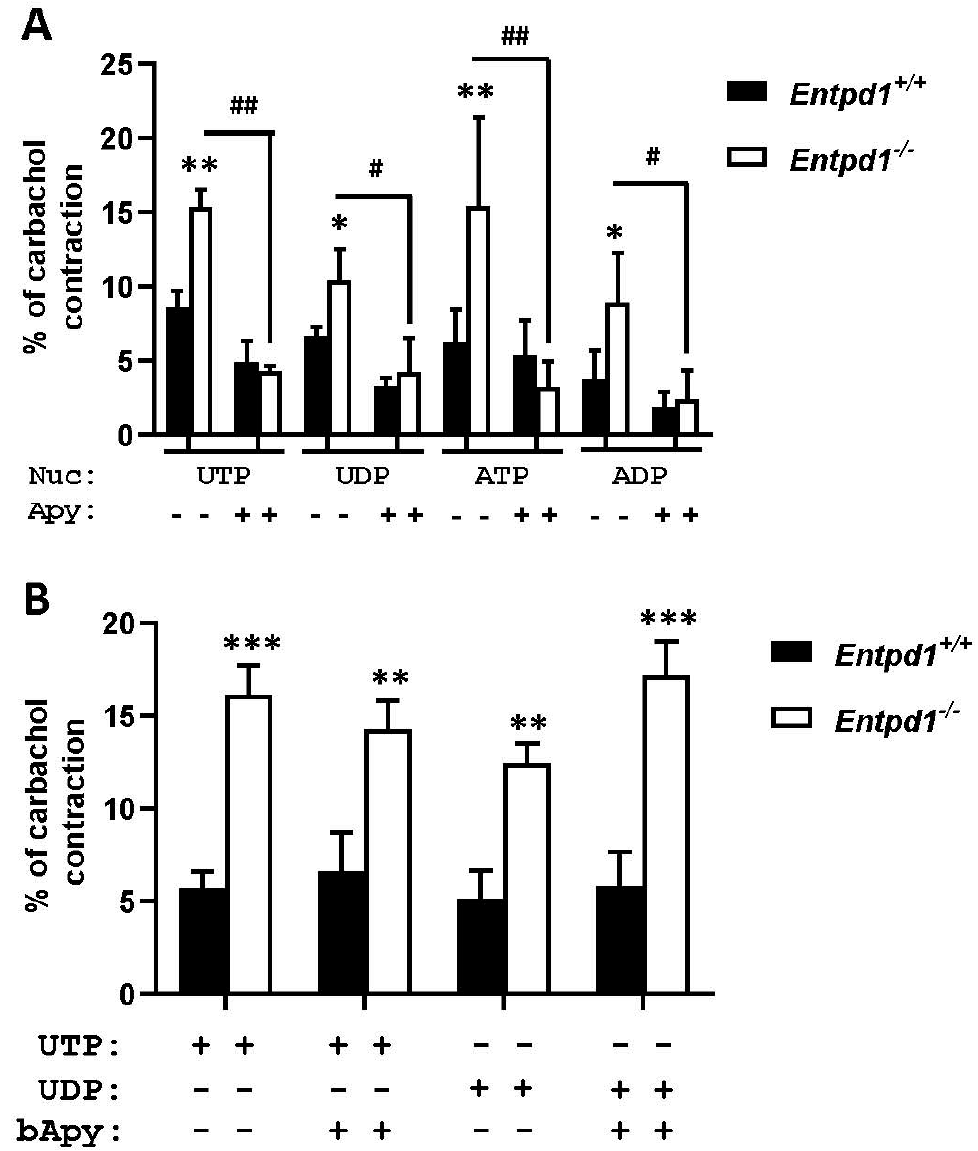
Figure 7. Effect of apyrase (Apy, 2 U/mL) ( A ) and the same amount of boiled apyrase (bApy) ( B ) on contraction induced by 100 µM ATP, ADP, UTP, or UDP on strips from male mouse bladders. Data presented are the mean ± SEM of four contraction experiments with strips from different mice. One symbol p < 0.05, two symbols p < 0.01, and three symbols p < 0.001. * Contraction in Entpd1 − / − bladders compared to contraction in WT; # Contraction in Entpd1 − / − bladders without apyrase compared to Entpd1 − / − bladders in presence of apyrase. There was no significant difference for WT bladders in presence or absence of apyrase or boiled apyrase.